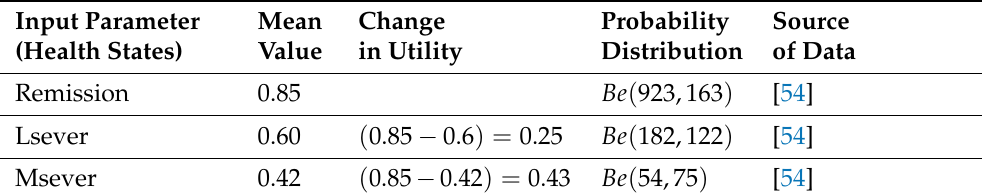
Table 2. The states of mental health and their corresponding utility values, as suggested in [54].